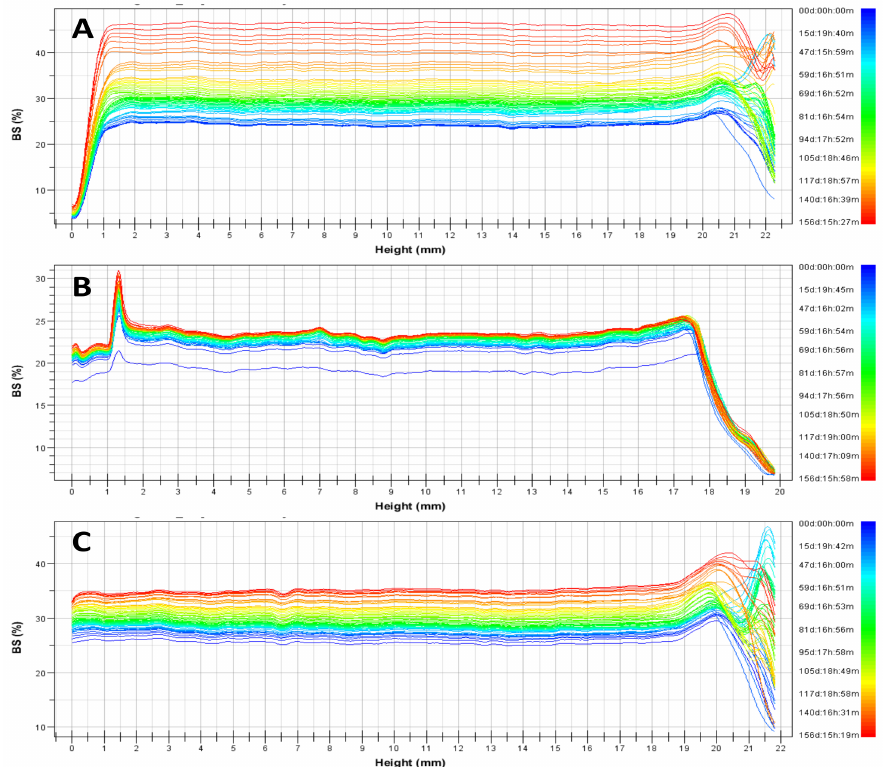
Figure 3. Representative backscattering profiles and Turbiscan Stability Index (TSI) of liposomes ( A ), argan-liposomes ( B ), and argan-hyalurosomes ( C